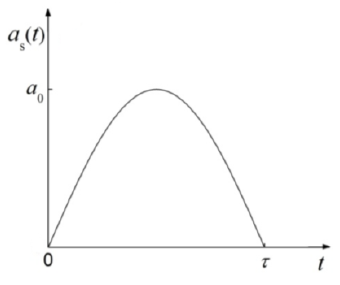
Figure 3. Half-sine acceleration pulse.